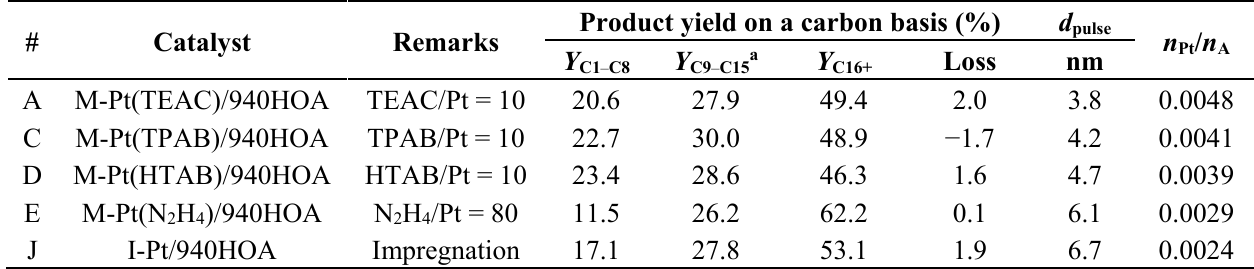
Table 4. Hydrocracking behaviors of Pt-loaded zeolite